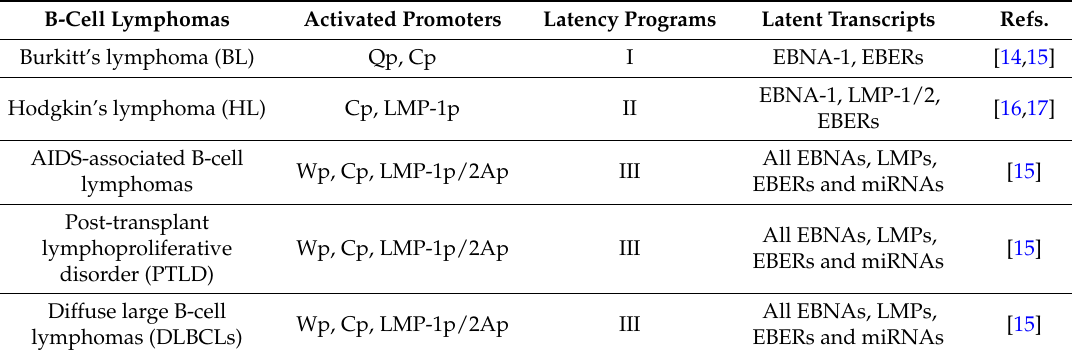
Table 1. EBV-associated B-cell lymphomas and associated gene expression